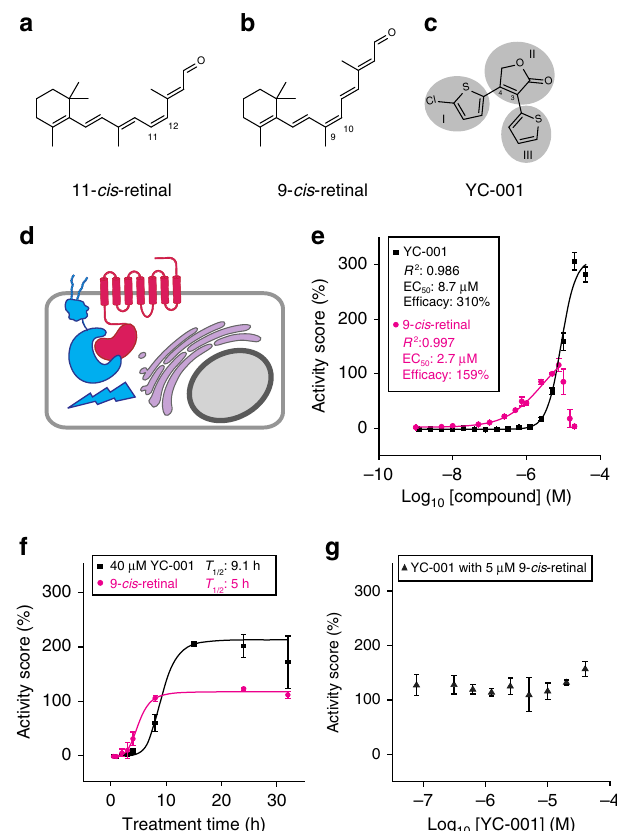
Fig. 1 YC-001 rescues P23H opsin from the ER to the plasma membrane. a – c Chemical structures of 11- cis -retinal, 9- cis -retinal, and YC-001, respectively. The three chemical moieties of YC-001 are shaded and numbered. d . Diagram of the β -Gal fragment complementation assay used for the HTS. Brie fl y, two complementary fragments of β -Gal (EA and PK) were individually fused with a plasma membrane-anchored peptide, the pleckstrin homology domain of phospholipase C δ (PLC-EA, in cyan), and the mouse P23H-opsin mutant (P23H-PK, in magenta), respectively. A U2OS stable cell line was generated that co-expressed both PLC-EA and P23H-PK. Owing to its inherent instability, P23H-PK accumulated in the ER, whereas PLC-EA remained on the plasma membrane, leading to a loss of β -Gal activity due to the separation of the two fragments of this enzyme. Upon treatment with an active compound that rescues the folding and transport of P23H opsin to the plasma membrane, a recovery of β -Gal activity is observed due to co-localization of PK and EA. e The activities of YC-001 (black boxes) and 9- cis -retinal (magenta circles) were tested in a dose- dependent manner employing the β -Gal fragment complementation assay. Each compound was preincubated for 24 h before β -Gal activity was tested. Activity scores were standardized to the effect of 5 µ M 9- cis - retinal as 100%. Dose dependence was fi tted by the Hill function with Origin software. R 2 , EC 50 ( μ M), and Max score for each compound were obtained from curve fi tting and are listed in the graph. The experiment was repeated three times. f Activities of 40 µ M YC-001 (black boxes) and 5 µ M 9- cis -retinal (magenta circles) were tested as a function of time with the β -Gal fragment complementation assay. The time course graph was fi tted with a Hill function and T 1/2 s were obtained and listed in the graph. This experiment was repeated twice. g Activities of YC-001 together with 5 µ M 9- cis -retinal were tested in a dose-dependent manner and plotted in black triangles. This experiment was repeated twice. The activity scores were plotted as the averages of three biological replicates, with the error bars as the